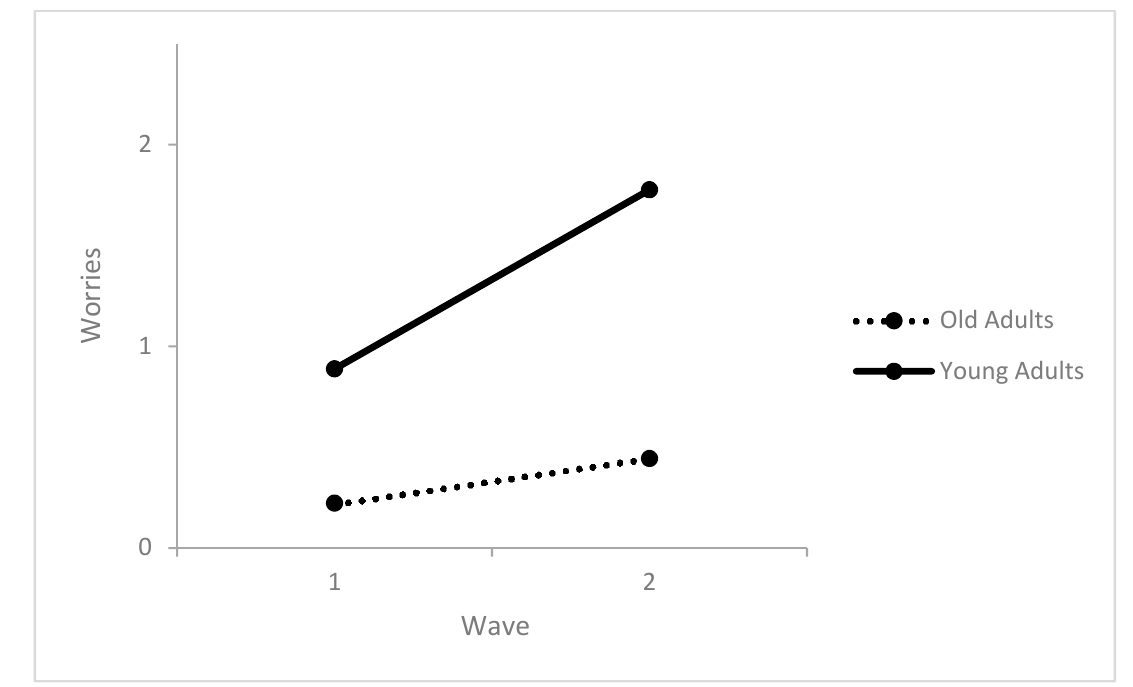
Figure 1. Interactions between the number of surveys and age predicting worries.